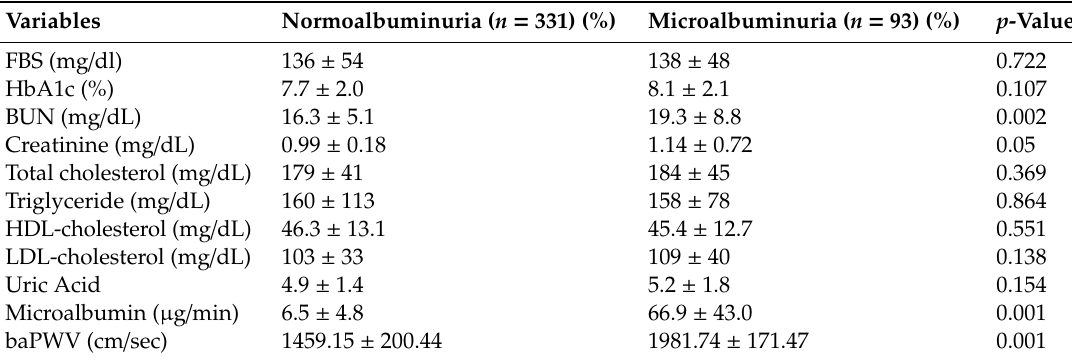
Table 2. Clinical characteristics of the study subjects.